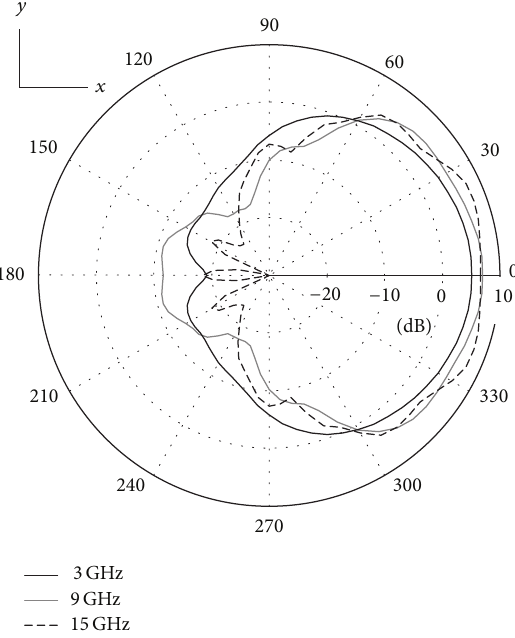
Figure 12: Radiation pattern of a conical antenna with elliptical aperture and reflector in the xy